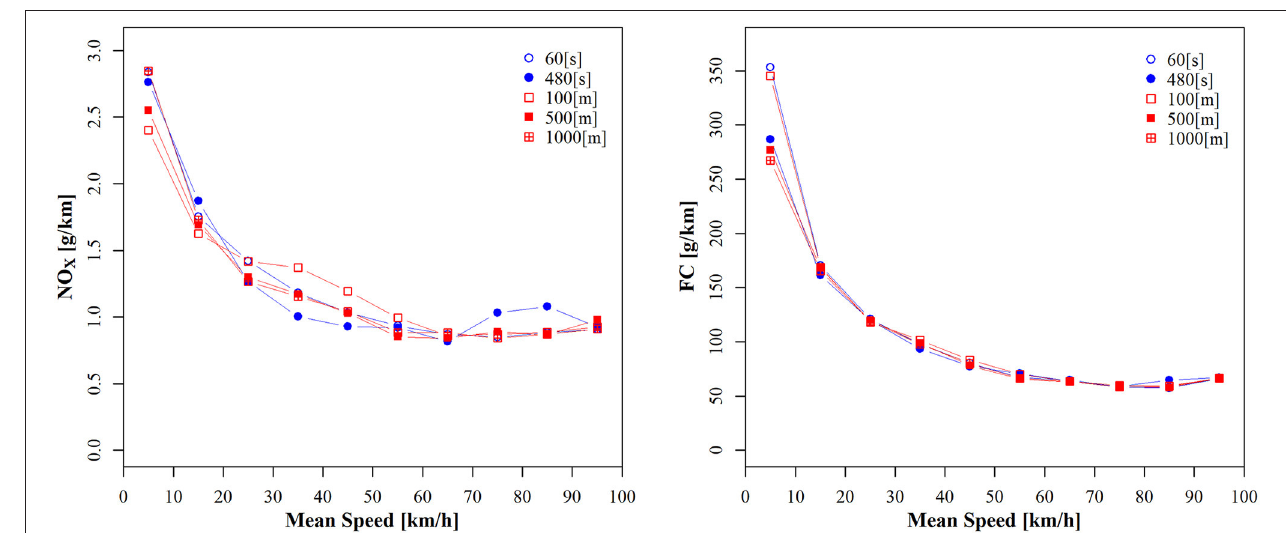
FIGURE 7 | NO x (left) and FC (right) emissions over mean speed for the alternative integrating options (Euro 4 case study).